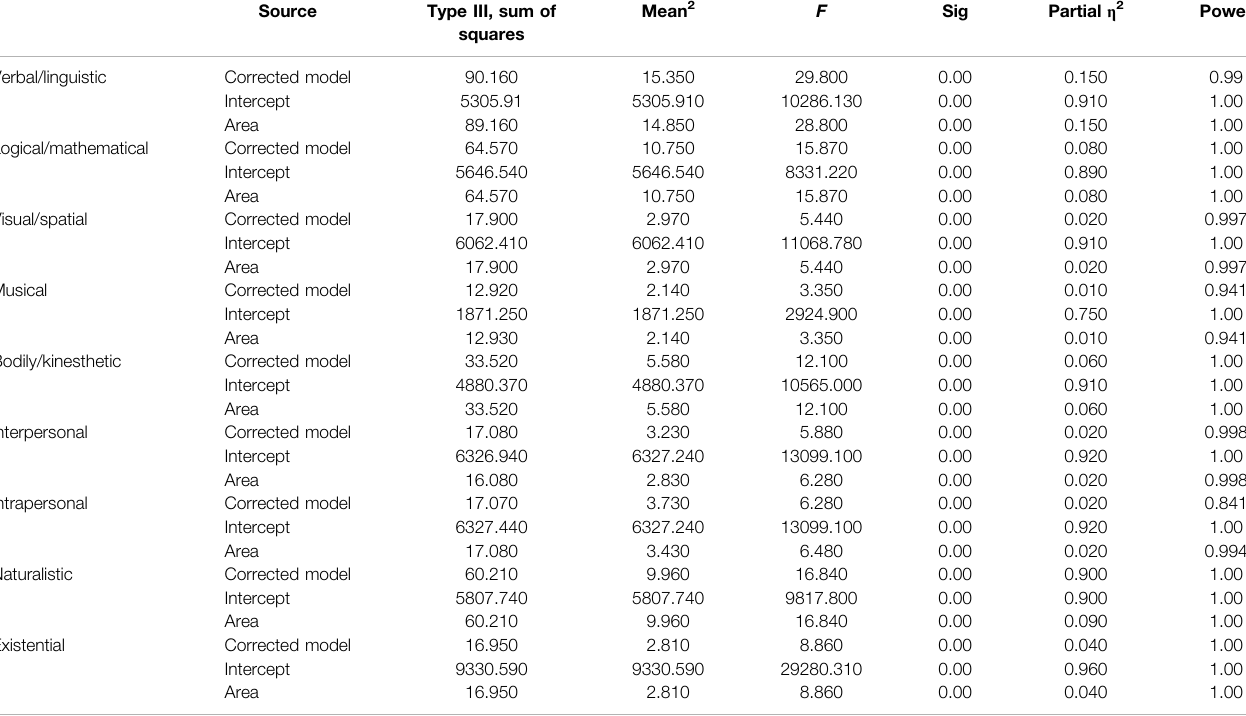
TABLE 4 | Test of between-subjects effects ( N (cid:1)